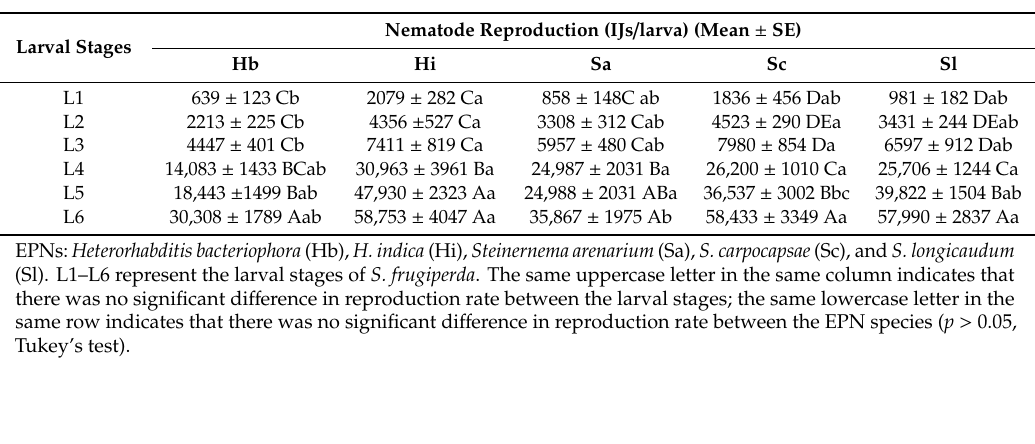
Table 3. Reproduction rates (mean ± SE ) of five entomopathogenic nematodes (EPNs) in the different larval stages of Spodoptera frugiperda. In a Petri dish, each EPN was applied at a density of 50 infective juveniles per larva in each S. frugiperda larval stage. Nematode numbers were then counted for 15 days after treatment.